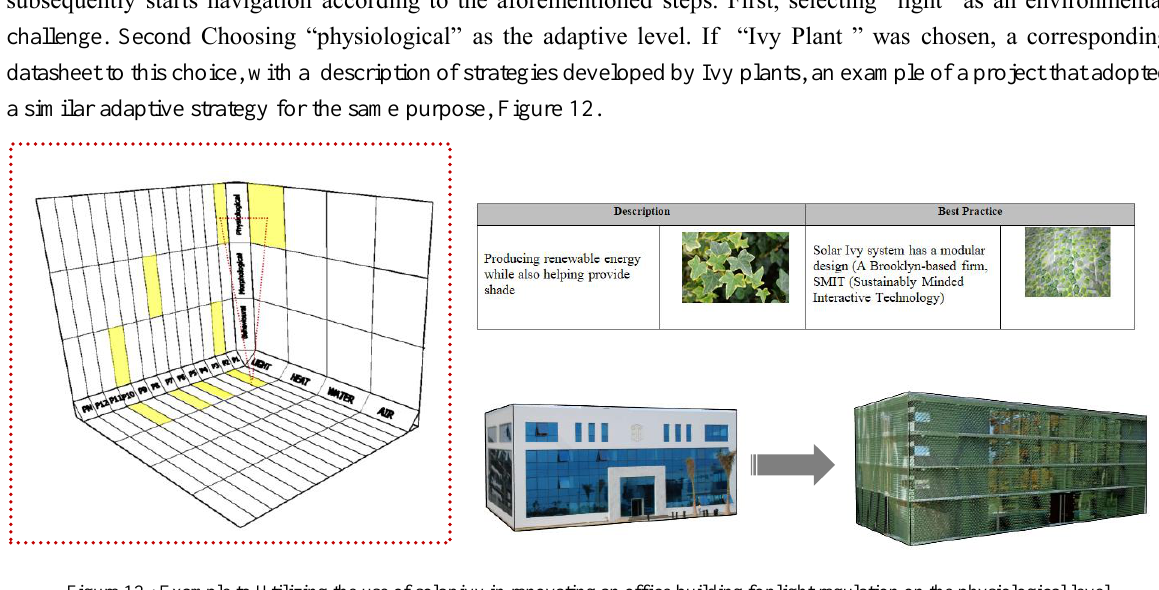
Figure 12 : Example to Utilizing the use of solar ivy in renovating an office building for light regulation on the physiological